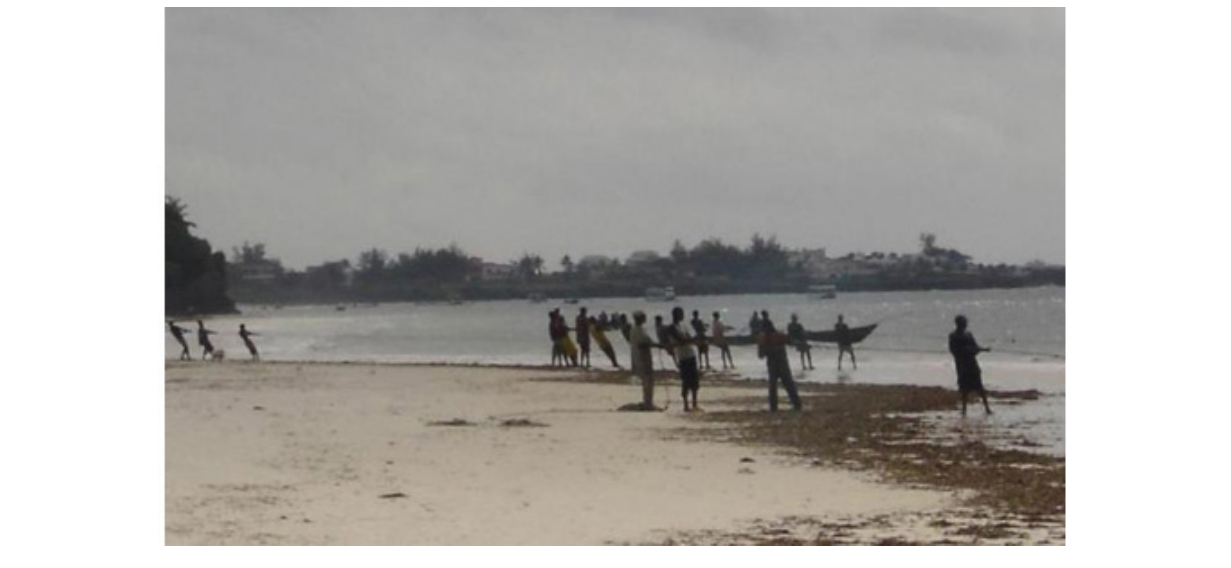
Fig. 2. Two fisher crews dragging beach seine nets in inshore areas in Mombasa. Photo by Louisa